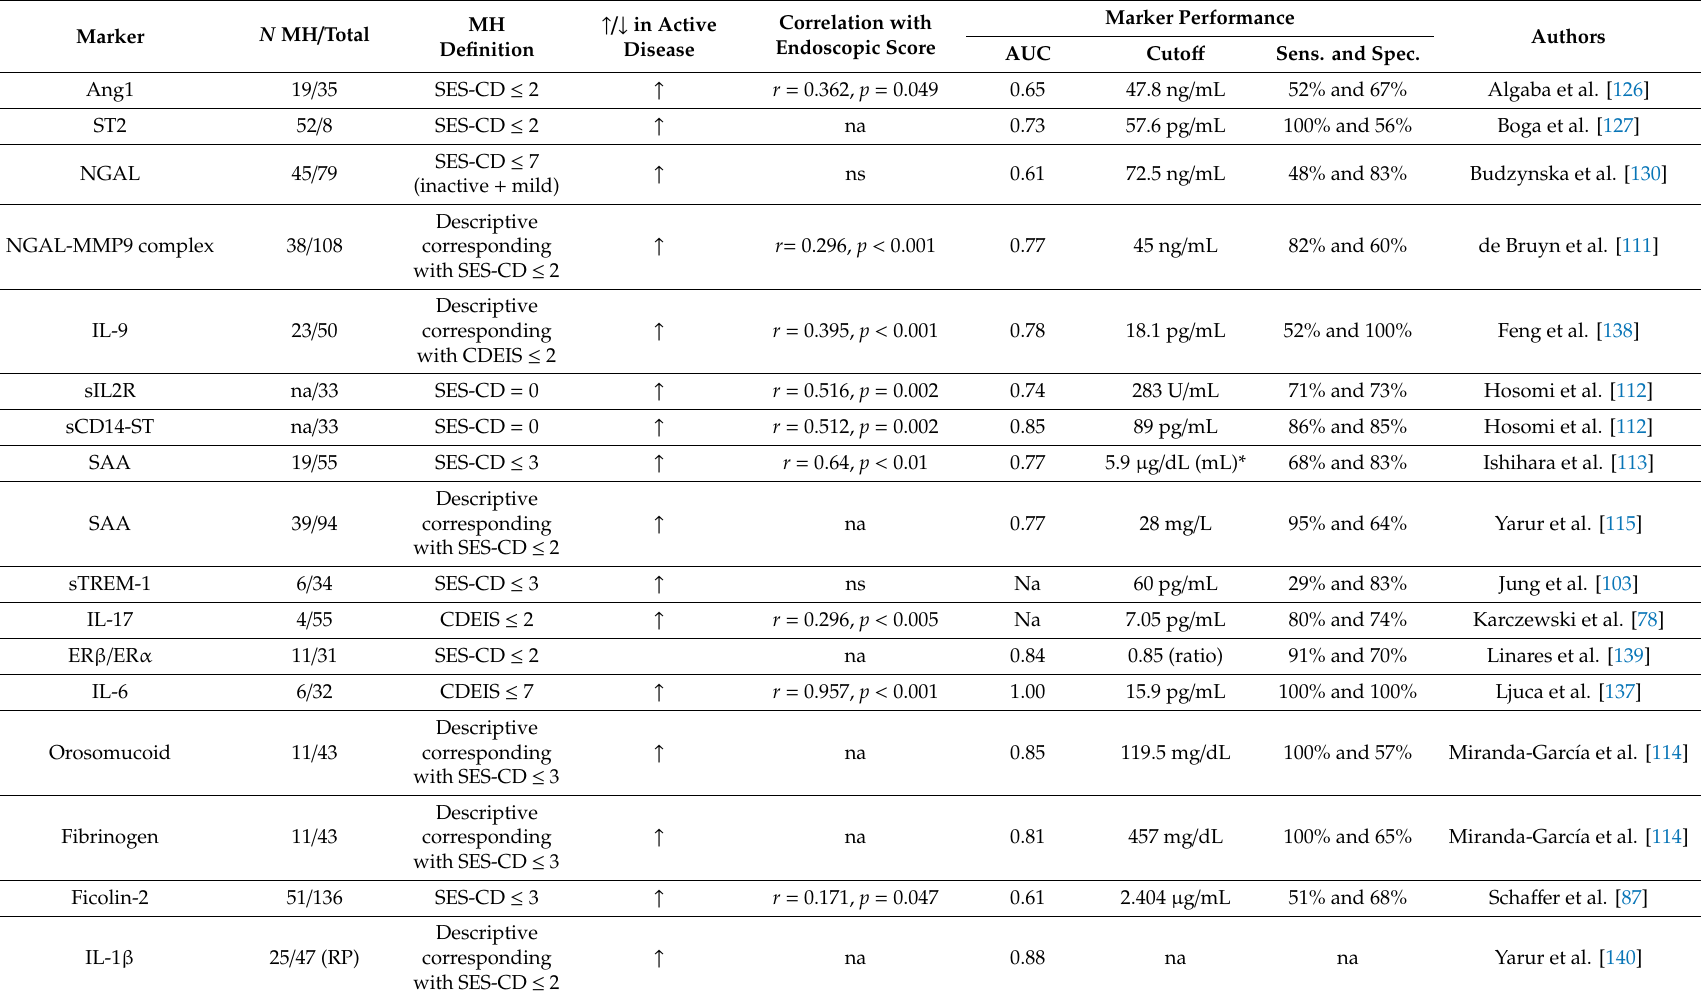
Table 9. Diagnostic performance of other serum-based markers in MH detection in Crohn’s